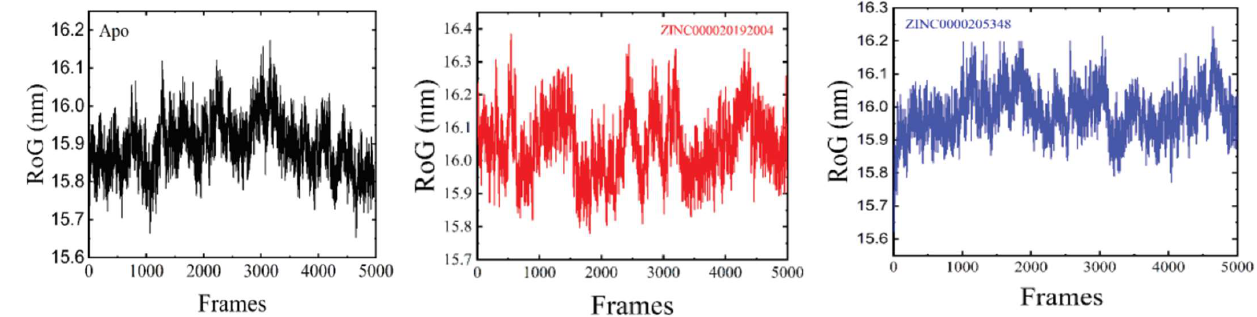
Figure 9. RoG of the apostate, ZINC000020192004 and ZINC000020530348. The number of frames is shown on the x-axis.